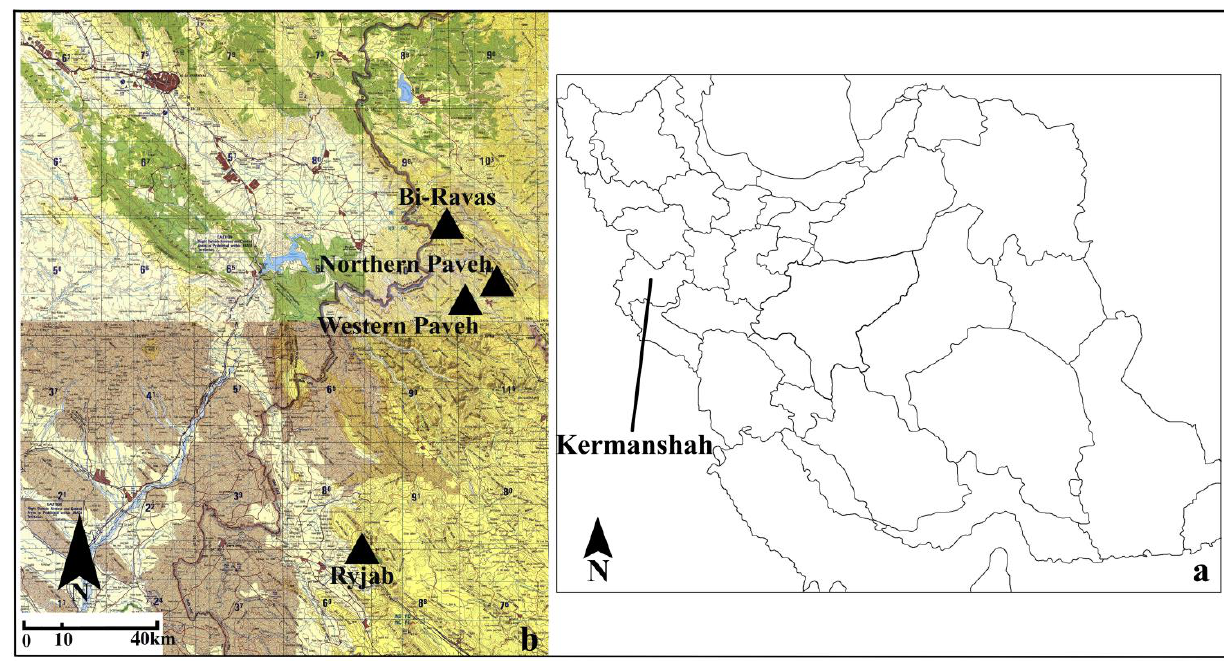
Figure 1. ( a ) Map showing the location of Kermanshah province in western Iran; ( b ) Map showing location of sites in Kermanshah